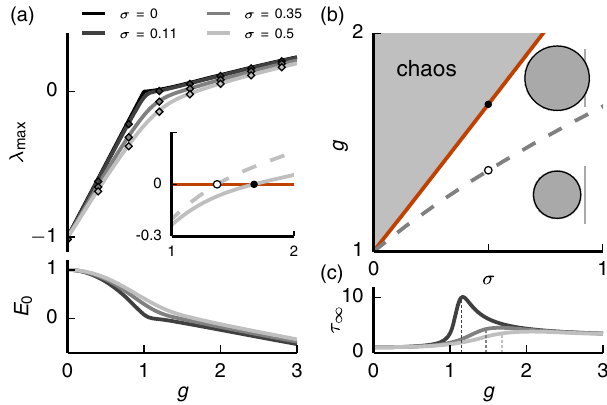
FIG. 3. Transition to chaos. (a) Upper part of vertical axis: Maximum Lyapunov exponent λ as a function of the coupling max strength g for different input amplitude levels. Mean-field prediction (solid curve) and simulation results (diamonds). We ffiffiffiffiffiffiffiffiffiffiffiffiffiffiffiffiffiffiffi p show a comparison to the upper bound − 1 þ g h½ ϕ 0 ð x Þ(cid:2) 2 i (dashed curve) for σ ¼ 0 . 5 in the inset. Zero crossings are marked with dots. Lower part of vertical axis: Ground-state energy E 0 as a function of g . (b) Phase diagram with transition curve (solid red curve) obtained from Eq. (20) and necessary condition [Eq. (18) with equal sign] (gray dashed curve). Dots correspond to zero crossings in the inset in panel (a). We show the disk of eigenvalues of the Jacobian matrix in Eq. (19) for σ ¼ 0 . 8 and g ¼ 1 . 25 (lower) and g ¼ 2 . 0 (upper) centered at − 1 in the ffiffiffiffiffiffiffiffiffiffiffiffiffiffiffiffiffiffiffi p complex plane (gray dots). The radius ρ ¼ g is h½ ϕ 0 ð x Þ(cid:2) 2 i obtained from random matrix theory (black circle). The vertical line is at zero. (c) Asymptotic decay time τ ∞ of the autocorre- lation function. Vertical dashed lines mark the transition to chaos. The color code is the same as in panel (a). The network size in the simulations is N ¼ 5000